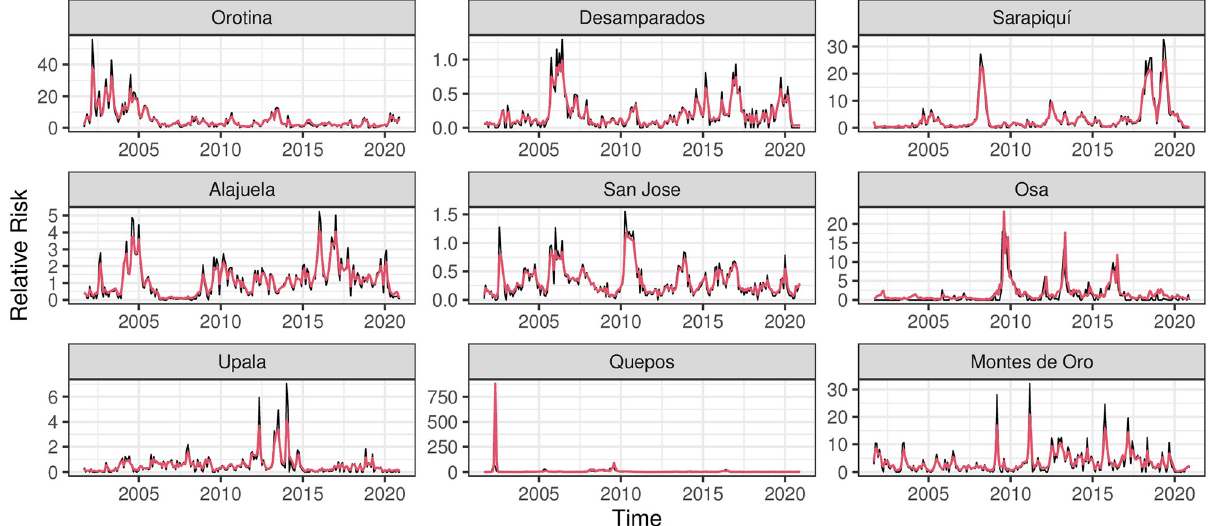
Fig 3. Comparison over the fitting period. Upper six panels: best cantons according to NIS metric. Lower three panels: worst cantons according to NIS metric. Black line: observed RR , red line: estimated RR and red shaded area: 95%-confidence predictive region.